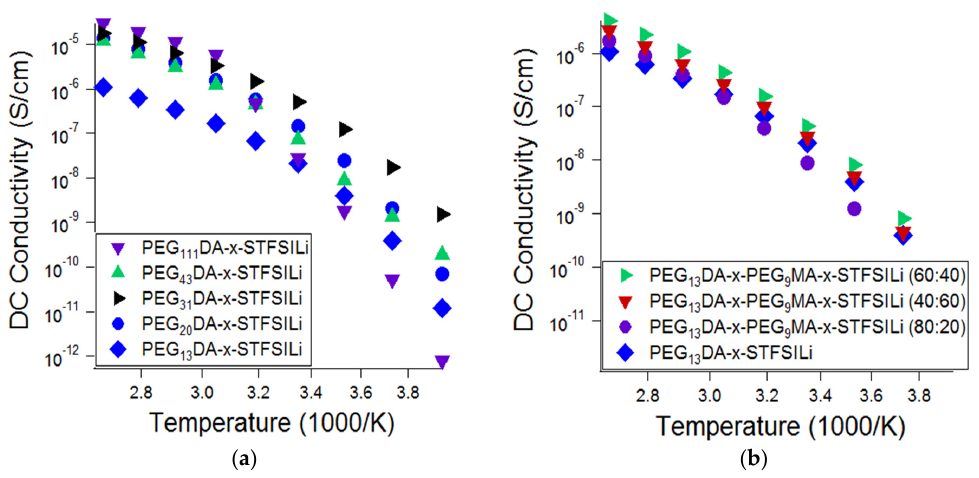
Figure 4. DC ionic conductivity from − 20 to 100 °C for crosslinked electrolytes with ( a ) varying PEG crosslinker length and ( b ) varying ratios of crosslinker PEGDA and side ‐ chain PEGMA. The lithiated crosslinked electrolyte PEG 31 DA ‐ x ‐ PEG 14 MA ‐ x ‐ STFSILi was employed in a